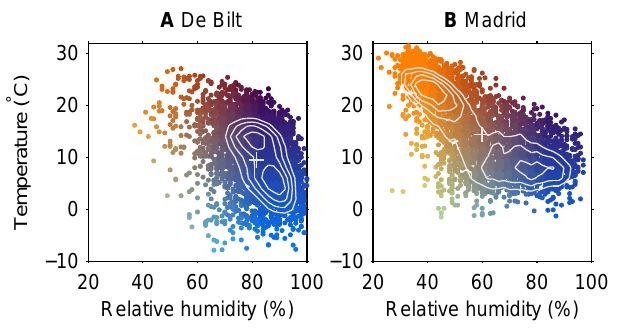
Fig. 3. Daily average temperature and relative humidity over the recent period 2001–2010 at De Bilt (A) and Madrid (B) . Contour lines indicate the shape of the density maxima for the complete cli- mate record. Crosses indicate mean values of RH and T . Observa- tions are taken from the European Climate Assessment & Dataset